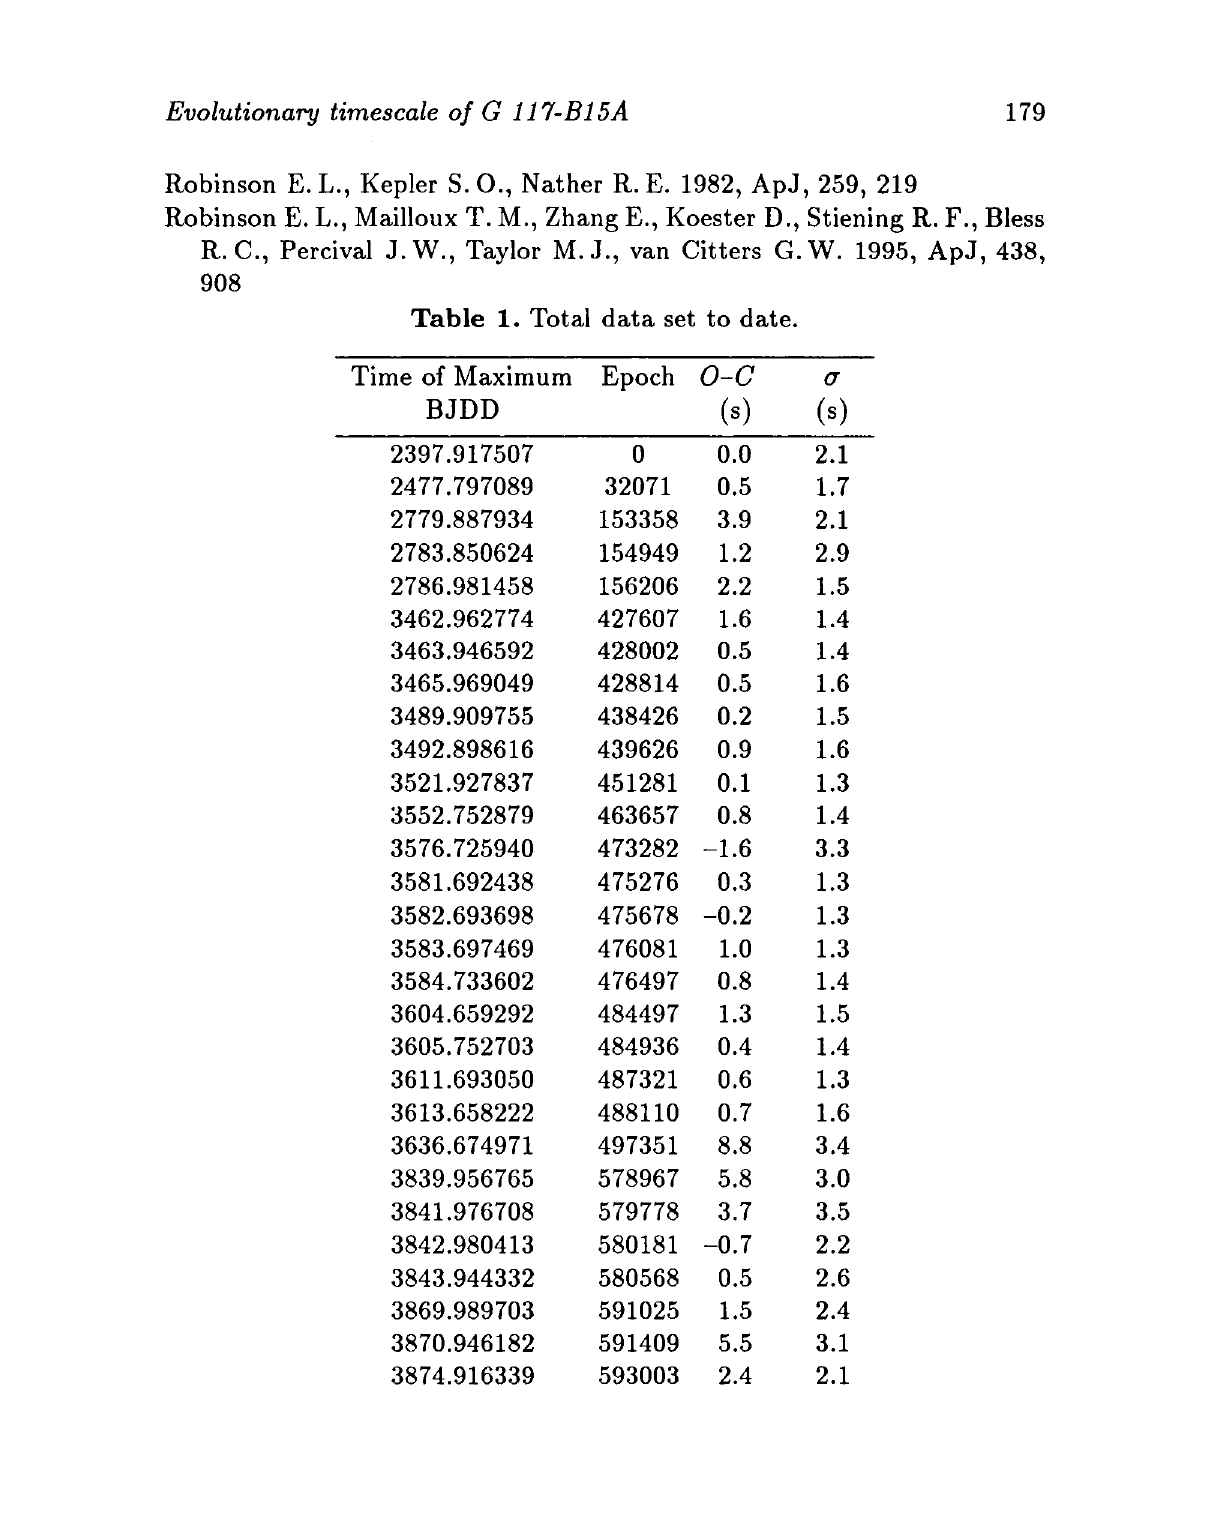
Table 1. Total data set to